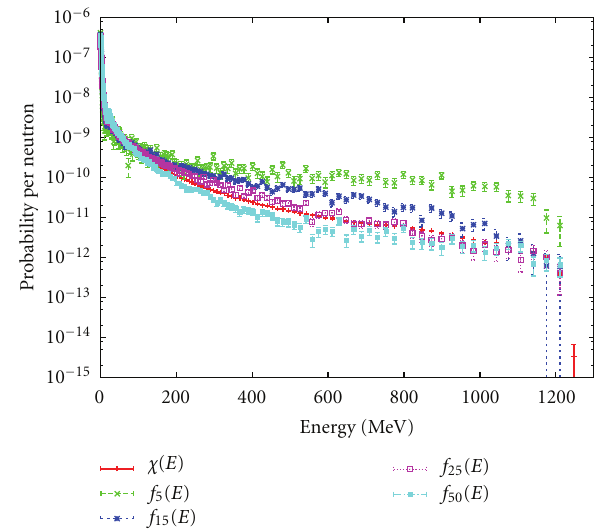
Figure 6: One-particle energy distributions f q ( E ) for di ff erent number of produced neutrons q and average spectrum χ ( E ) calculated for the 0.2 cm thick target.